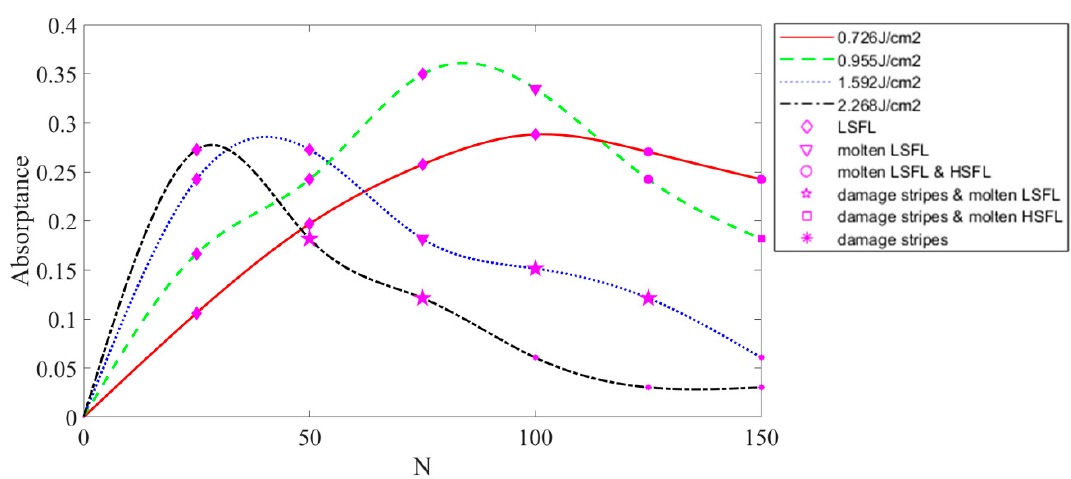
Figure 7. The value was slightly bigger than that of the relative absorptance of the smooth sample but far smaller than the relative absorptance of samples with high-quality LIPSS.